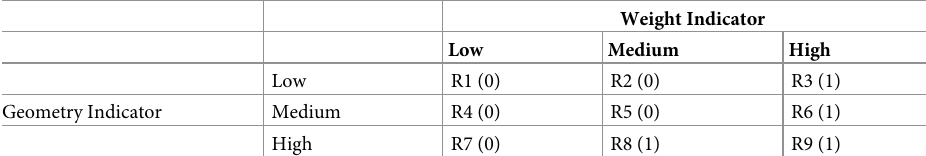
Table 2. Fuzzy logic rules for the DY eggs detection